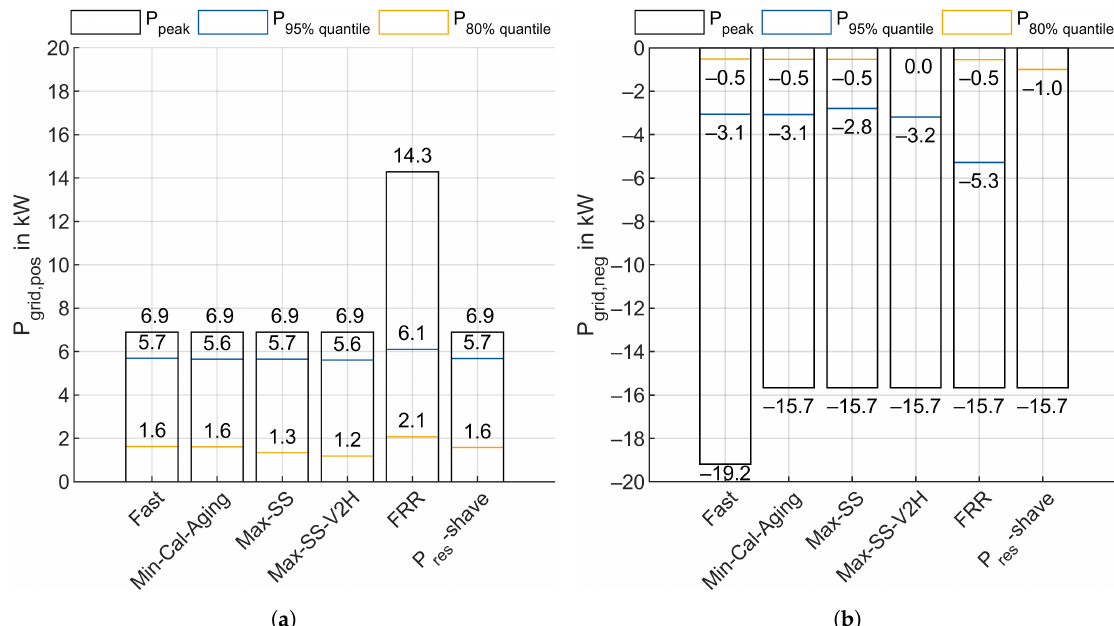
Figure 12. Power exchange of the household with the grid for the home charging scenario H and mobility profile Worker without SoC V 2 XLimit . ( a ) Positive power exchange (Household → Grid). ( b ) Negative power exchange (Grid →